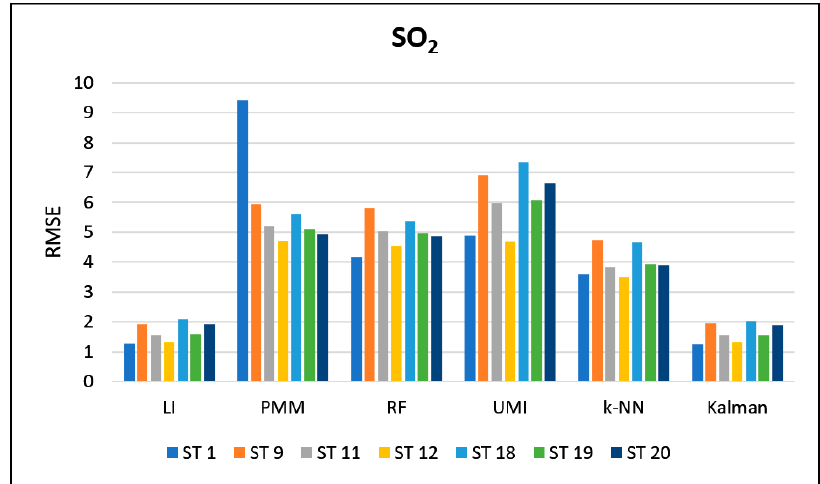
Figure 10. RMSE error for SO 2.